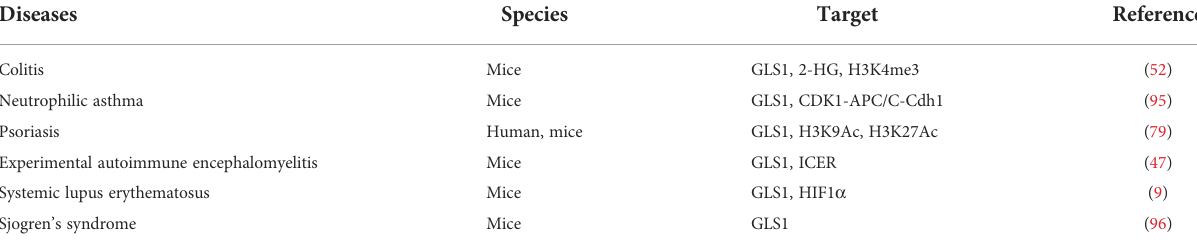
TABLE 1 Targets of glutamine metabolism in the regulation of autoimmune